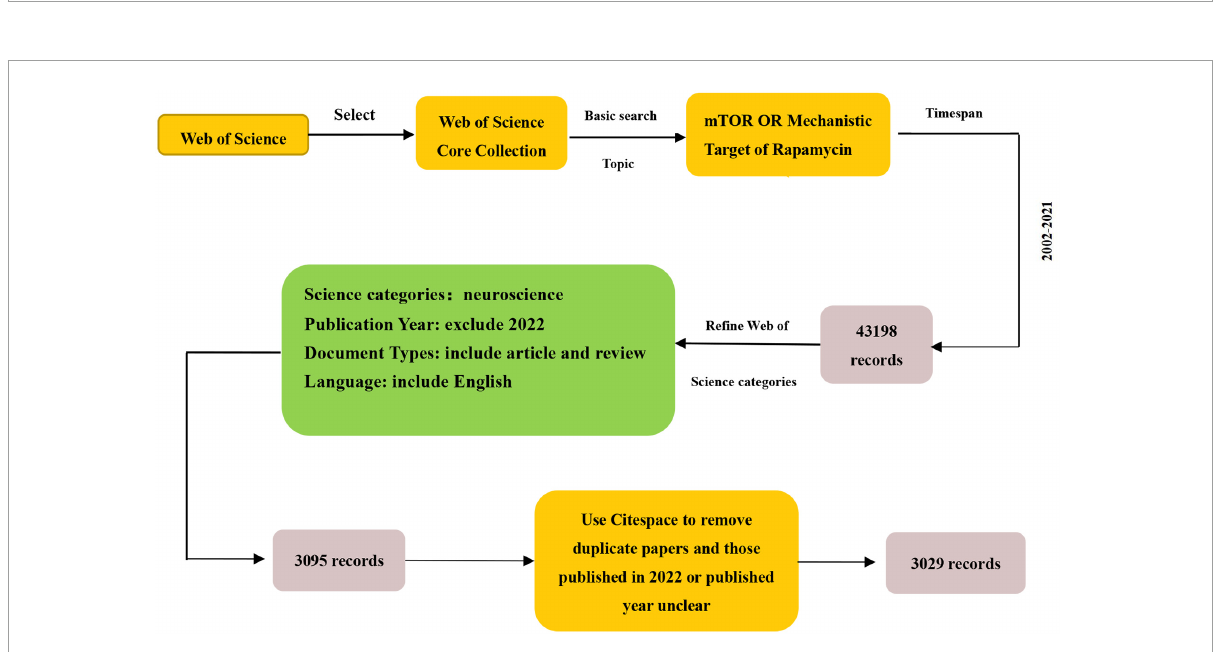
FIGURE2 Search flowchart detailing steps in the identification and screening of